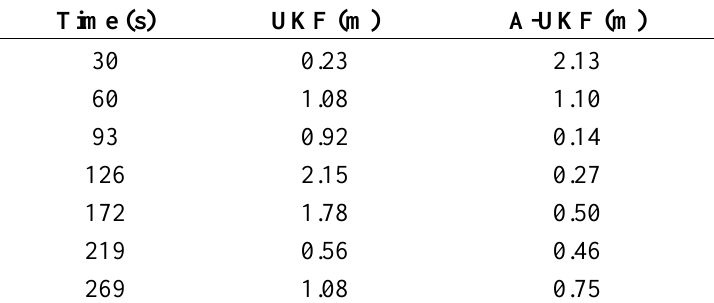
Figure 19. Estimated position based on UKF and A-UKF. Table 8. Residuals of the gross-error